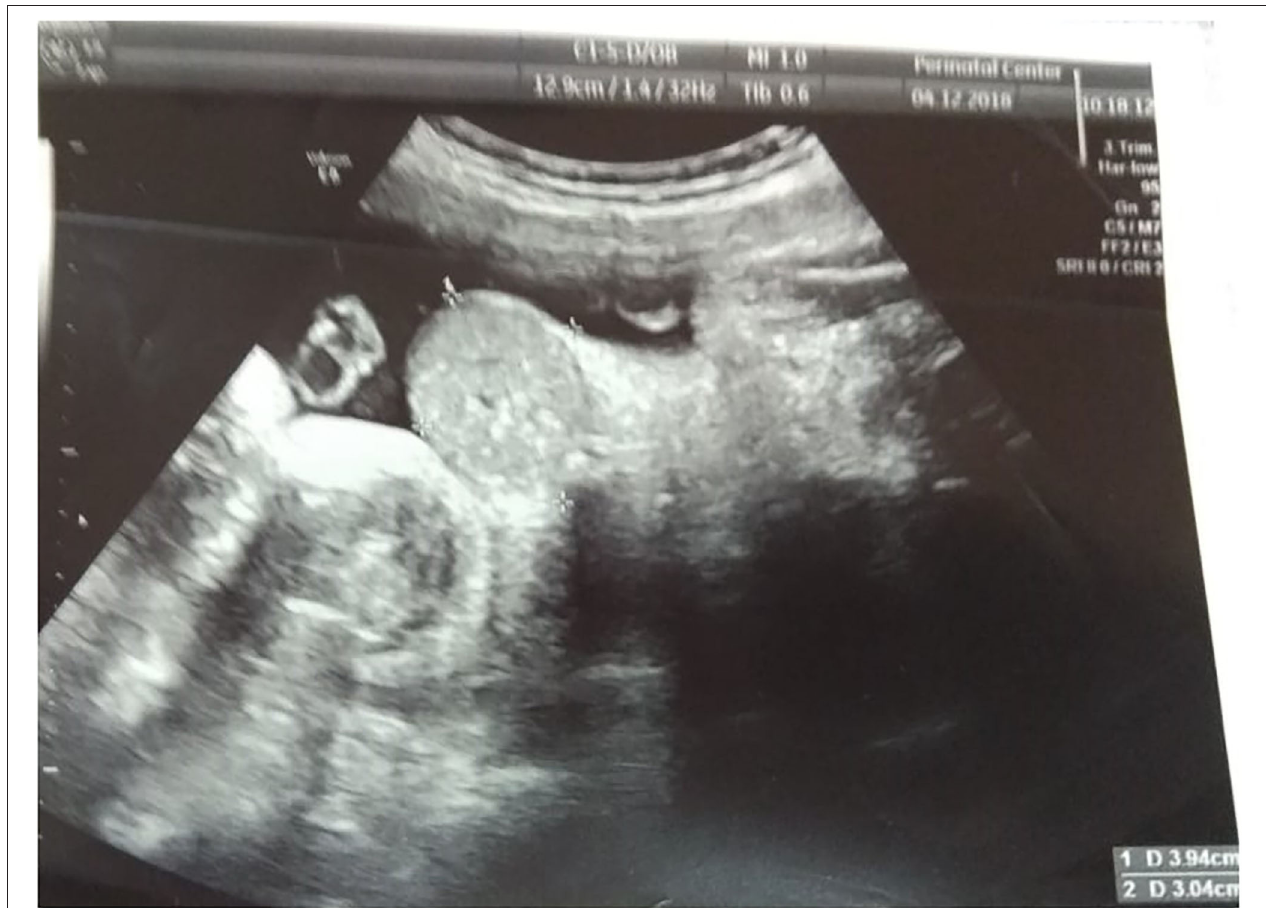
FIGURE 1 | Prenatal US on 34 weeks of